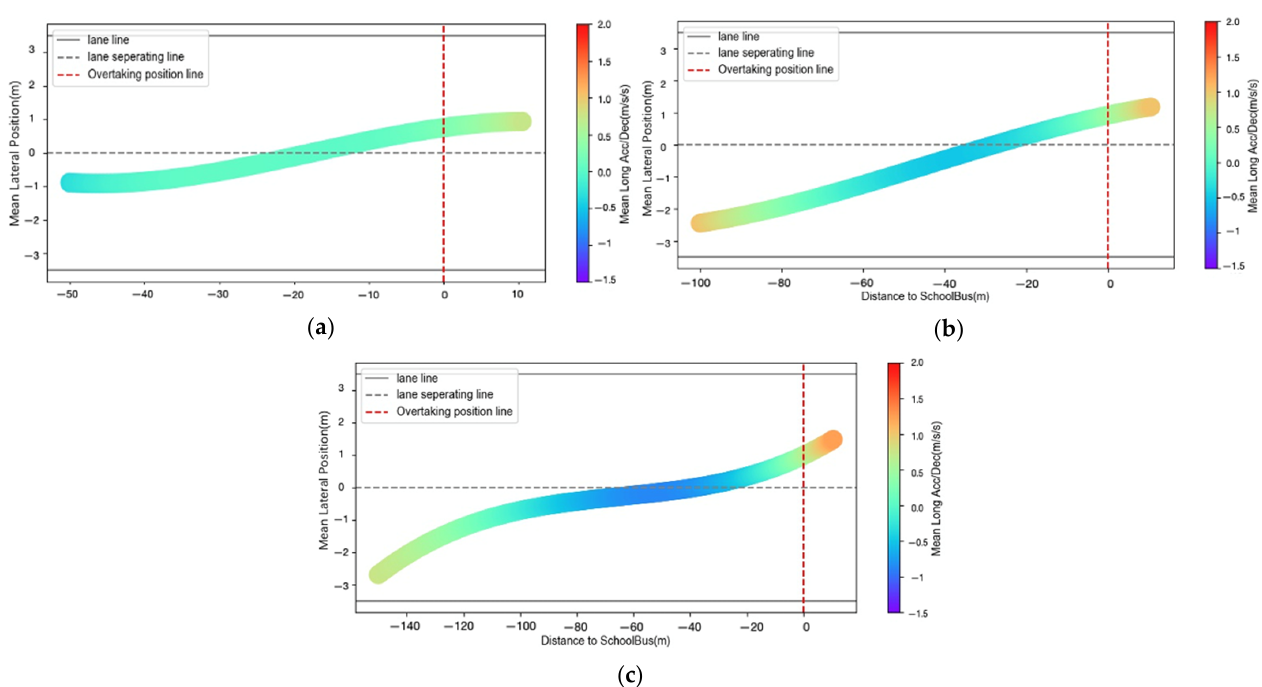
Figure 4. ( a ) Mean longitudinal Acc/Dec profiles when IDCTS = 50 m and volume = 500 pcu/h; ( b ) mean longitudi- nal Acc/Dec profiles when IDCTS = 100 m and volume = 1000 pcu/h; ( c ) mean longitudinal Acc/Dec profiles when IDCTS = 150 m and volume = 1500